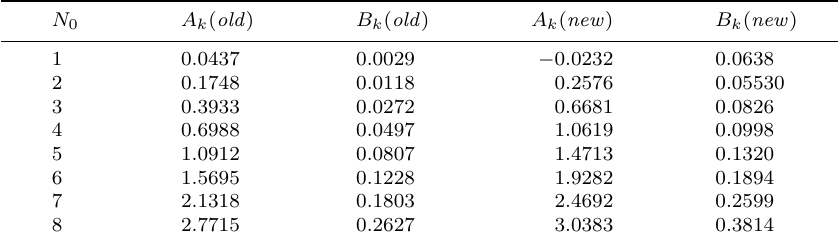
Table 1. The values of A k , B k for L = 15, γ = 2, δ = 0, I = 0. N